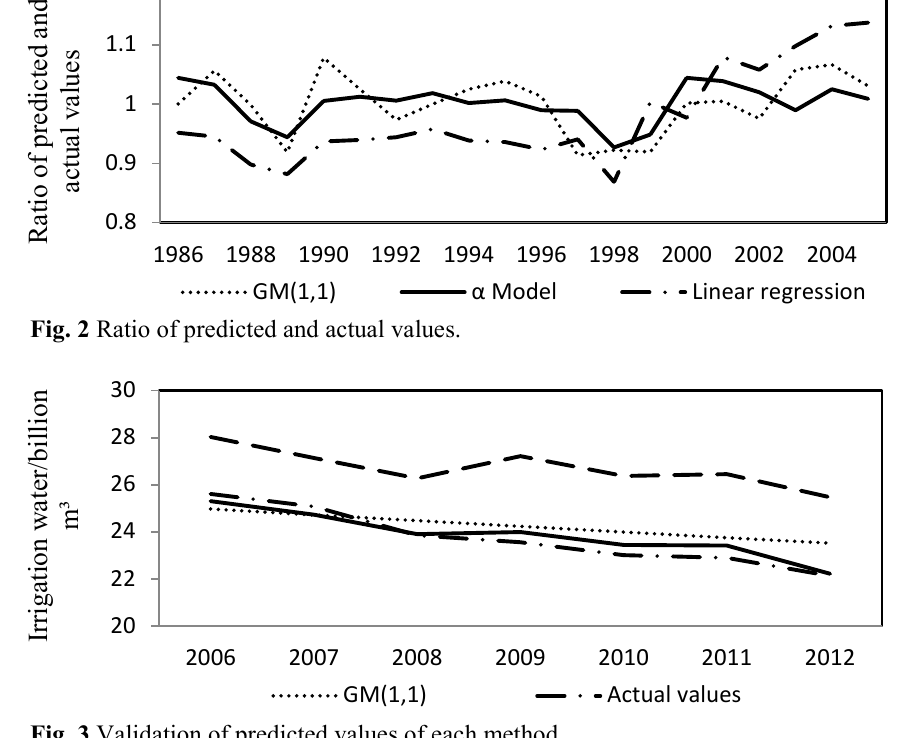
Fig. 3 Validation of predicted values of each